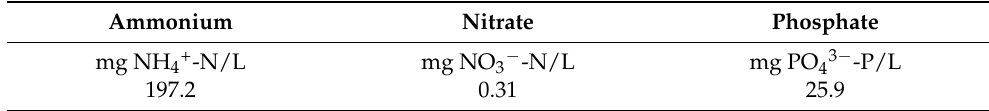
Table 2. Ammonium, nitrates, and phosphates concentrations in the filtered centrate (sampling period: January 2020). N to P molar ratio was about